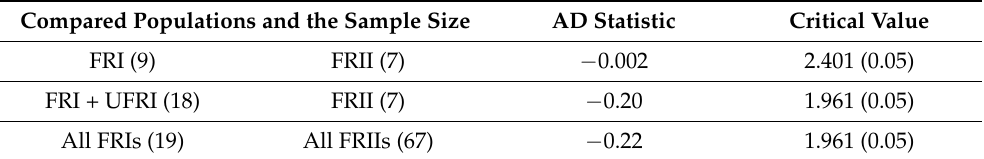
Table 2. Results of the Anderson-Darling test that has been used to assess the black hole masses of FRI and FRII quasars.